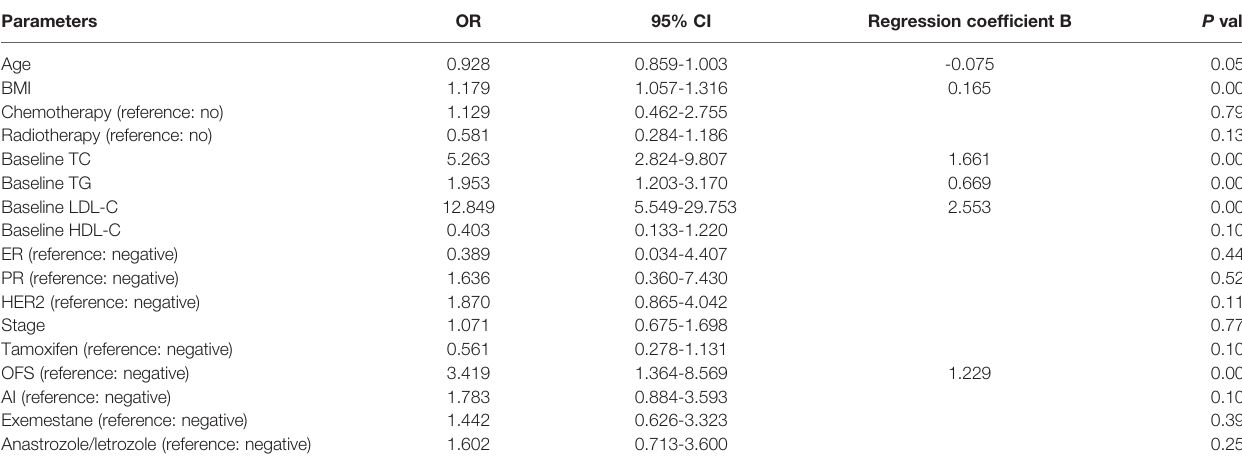
TABLE 2 | Univariate analysis of factors associated with lipid events.